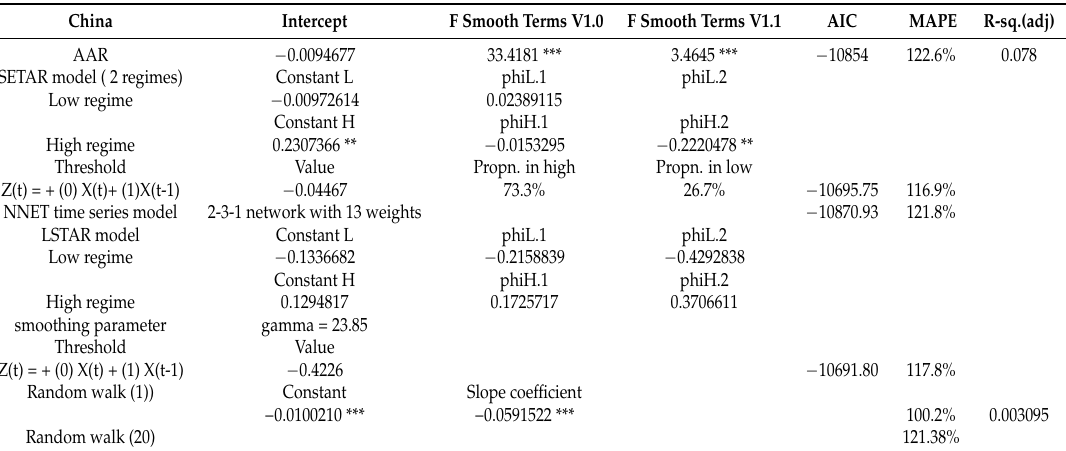
Table 5. Non-linear models-China.